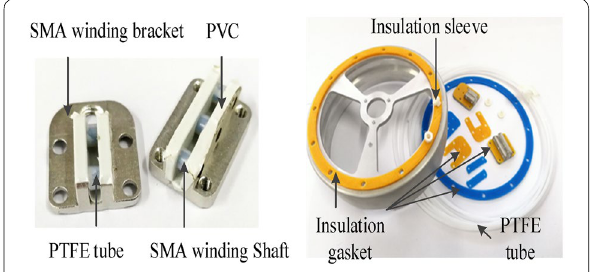
Figure 9 SMA-spring combination driving source